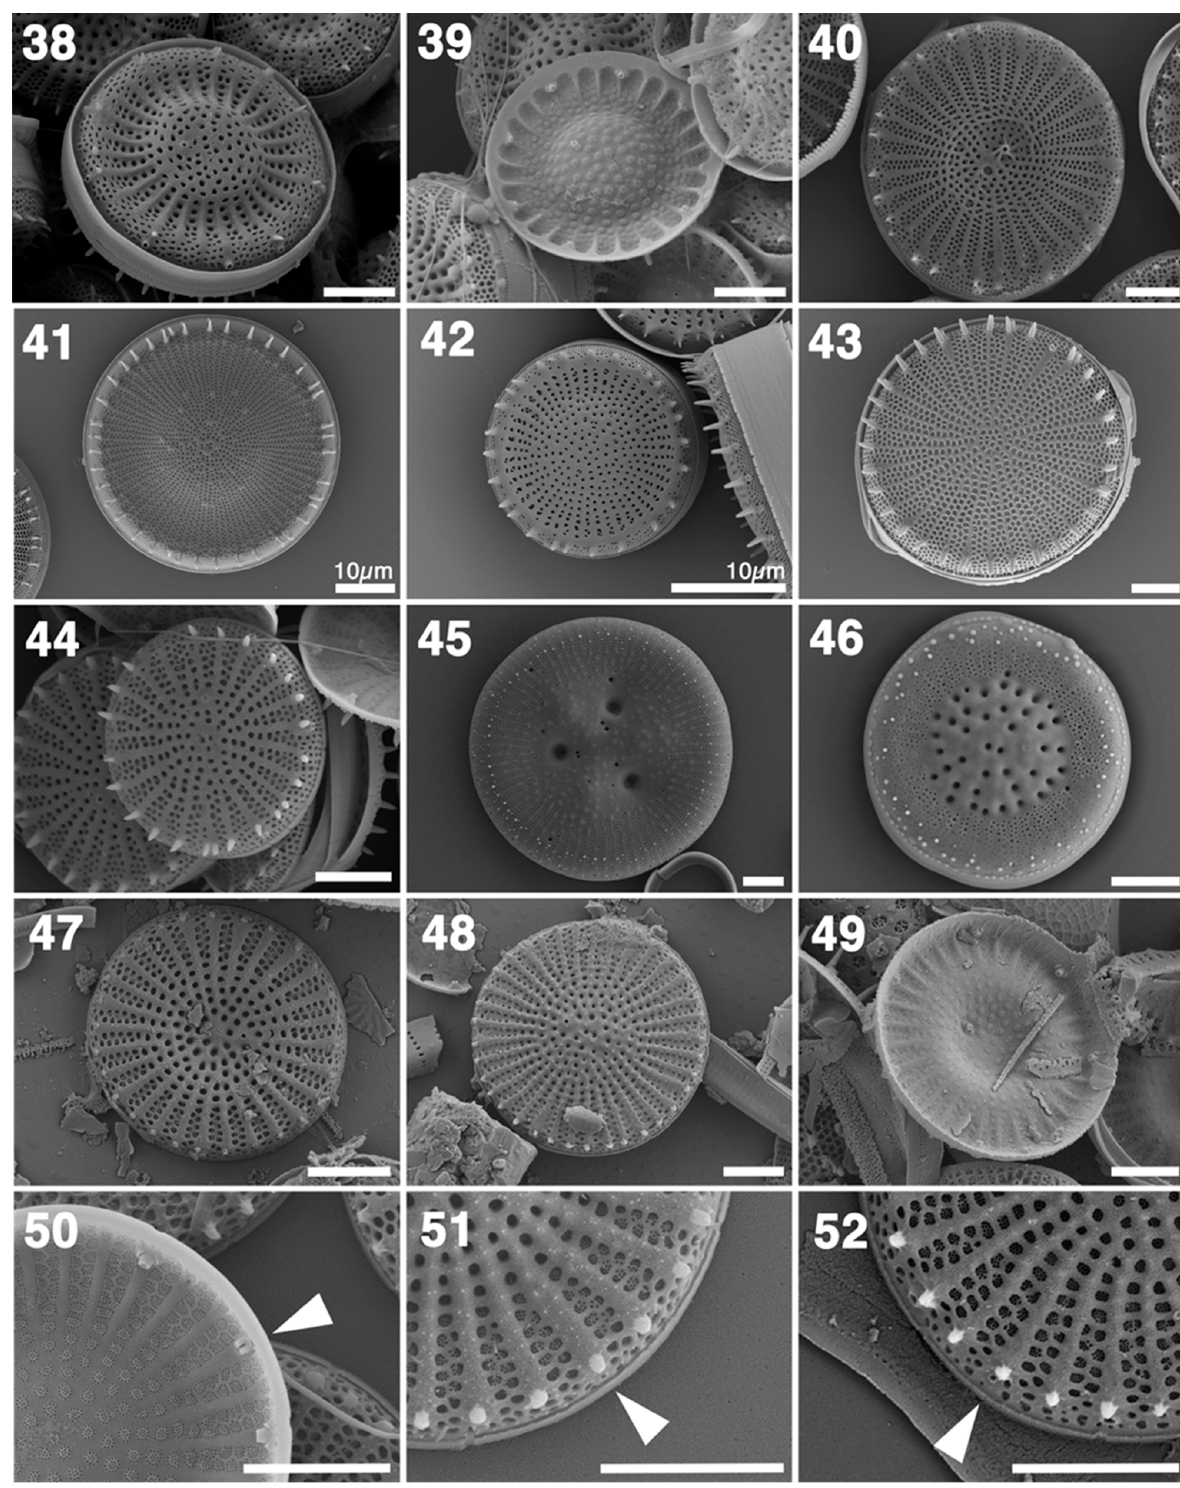
Figure 5. ( 38 – 52 ) SEM photographs of the internal and external ultrastructure of various strains. ( 38 – 39 ) strain HZ1 Cyclostephanos dubius; ( 40 ) strain QN14 C. delicatus; ( 41 ) strain LD1 Stepha-nodiscus niagarae; ( 42 ) strain DOL10 S. neoastraea; ( 43 ) strain TO6 S. hantzschii; ( 44 ) strain QC3 S. binatus; ( 45 ) strain RL1 Pantocsekiella ocellata; ( 46 ) strain DR1 Lindavia sp.; ( 47 – 49 ) C. makarovae from Lake Vielbecker See, Germany; ( 50 – 52 ) arrowheads mark the position of the internal and external openings of the rimoportula in C. makarovae comb. nov., ( 50 – 51 ) strain US5, ( 52 ) strain RIE1. Scale bars = 2 µm unless otherwise marked.